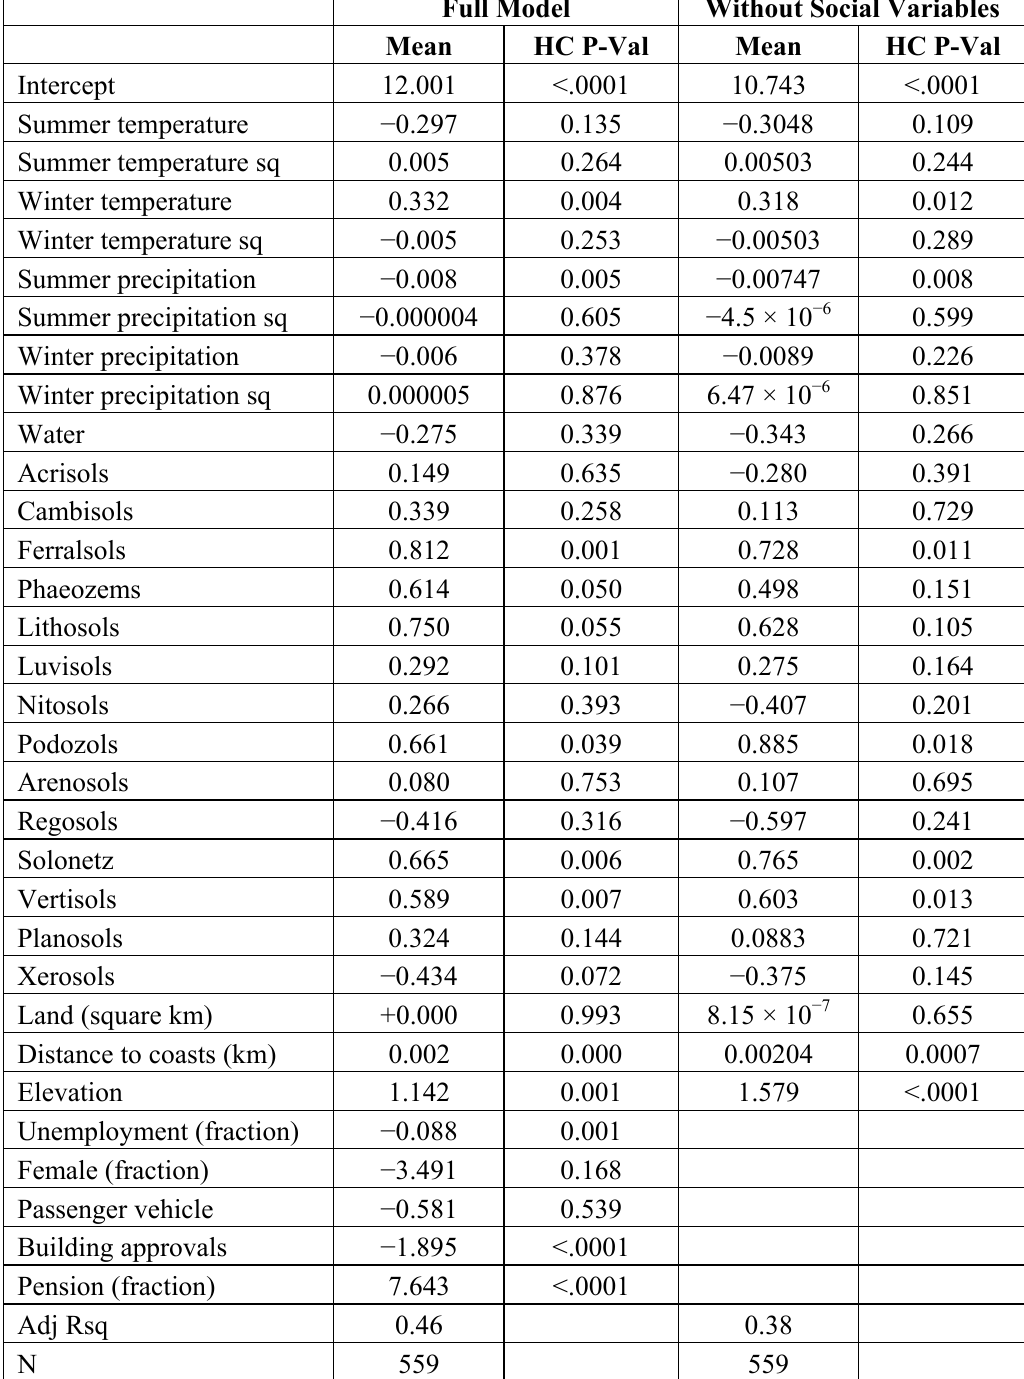
Table 6. Livestock revenue (in log) per 1,000 rural